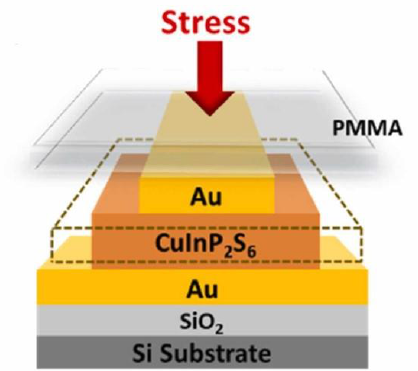
Figure 16. The schematic diagram of piezoelectric device based on CuInP 2 S 6 (CIPS) [63]. Reprinted from [63], copyright 2022, with permission from Elsevier.